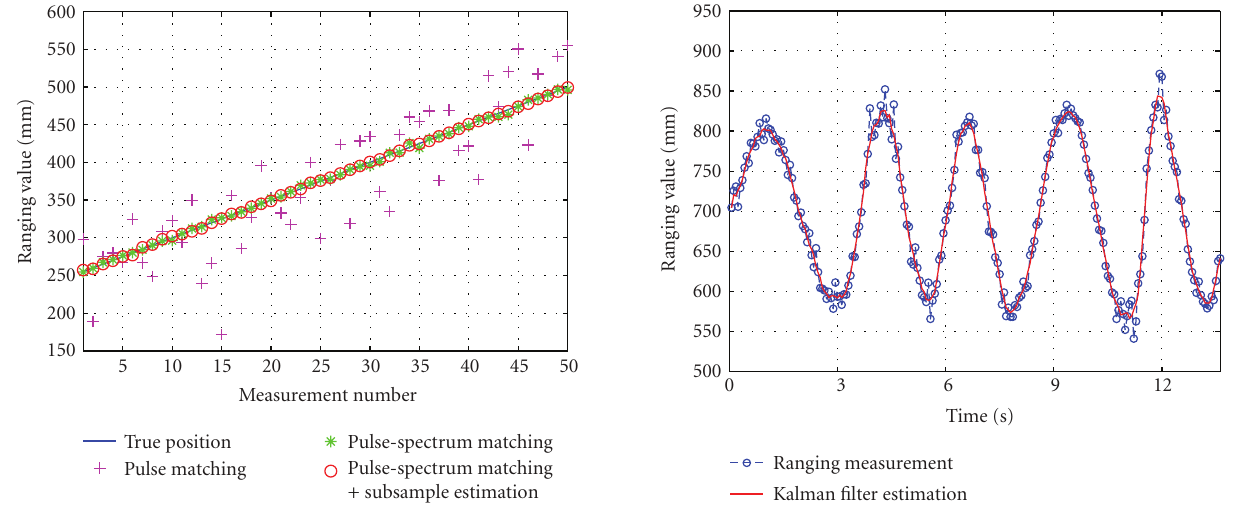
Figure 15: The estimated position by the Kalman filter tracking algorithm for the one-dimensional see-through-wall